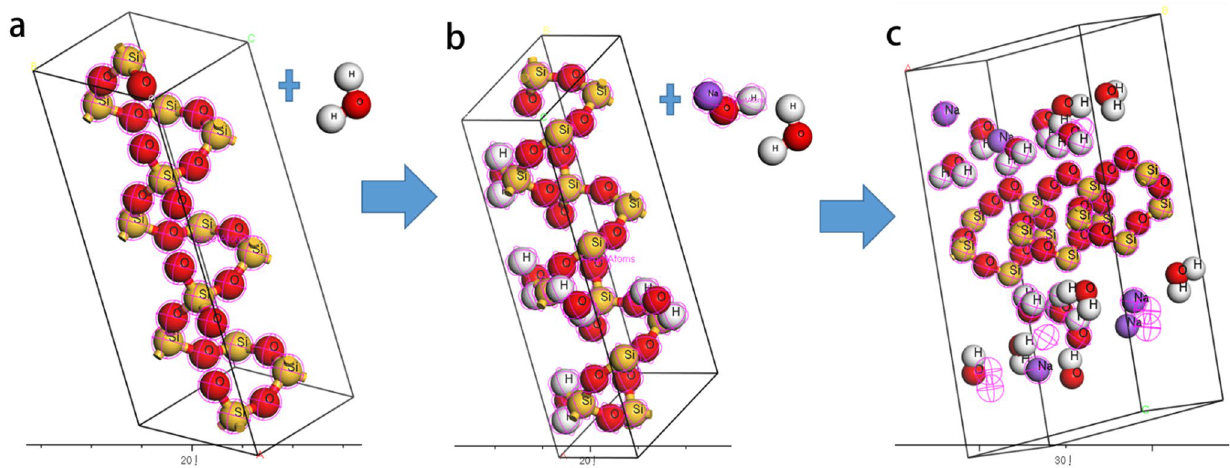
Fig. 5 a Molecular adsorption model for H 2 O molecule, b molecular adsorption model for hydrated quartz, c molecular adsorption model of NaOH ionized in H 2 O (adsorbate) over targeted hydrated